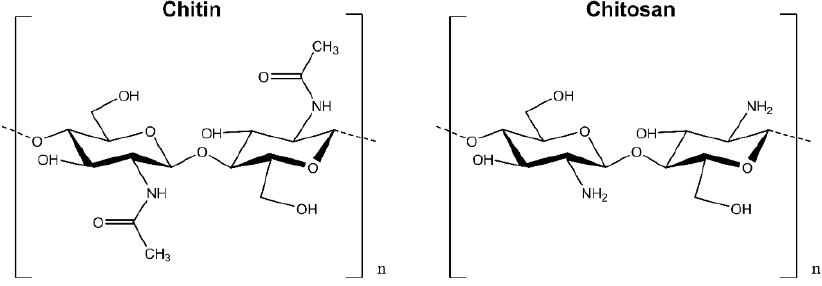
Figure 8. Chemical structure of Chitin and Chitosan.